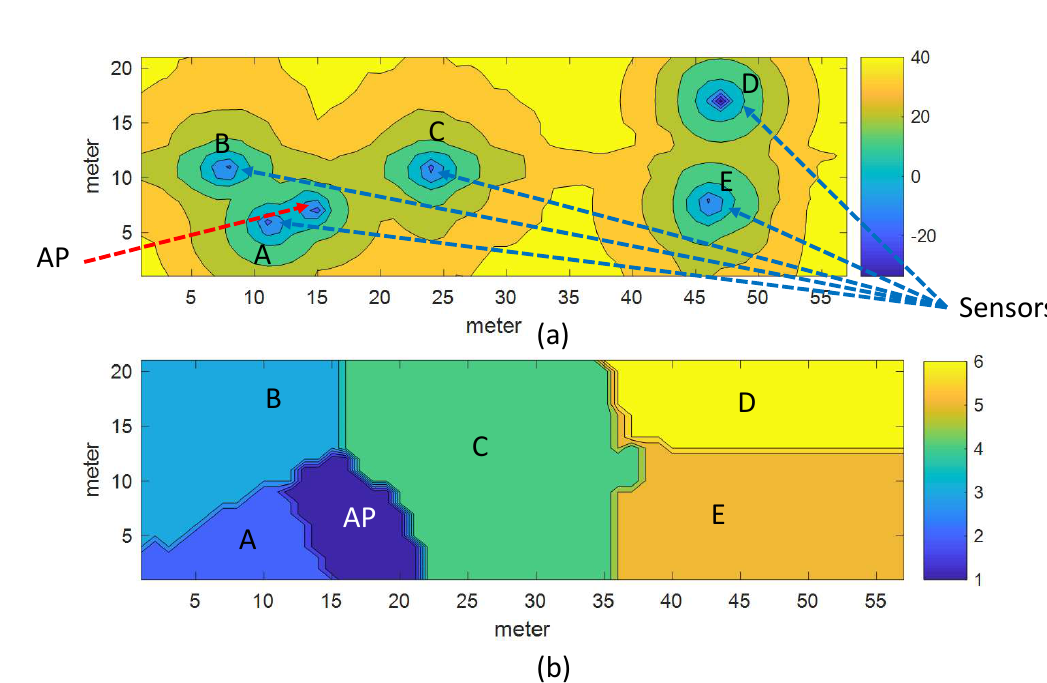
Figure 10. Zone allocation for Received Signal Strength Indication estimation on the basis of minimum path-loss ( a ) Combined path loss map of sensors and corresponding access point. ( b ) Calculated mask representing the device designation of a given region for the estimation of the radio